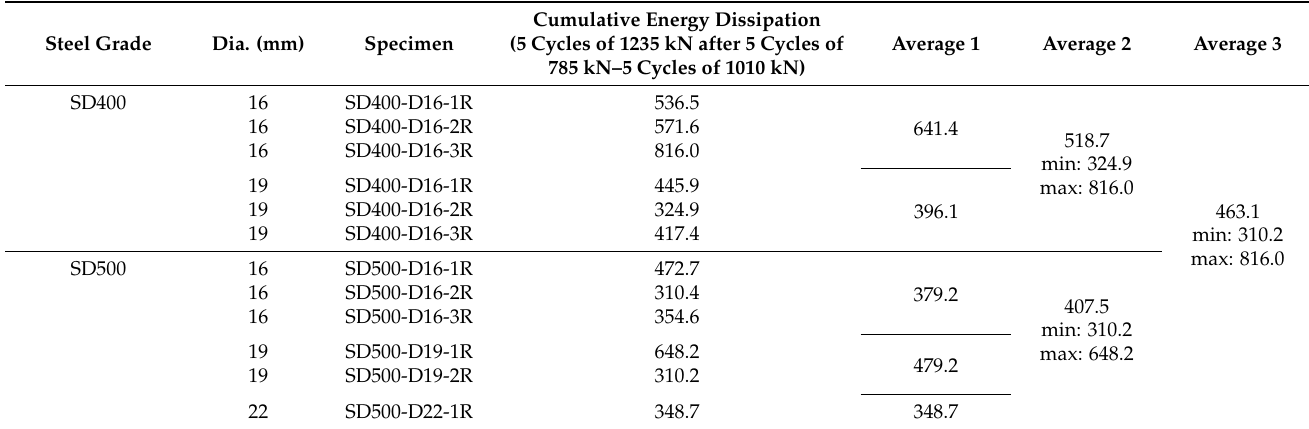
Table 15. Energy dissipation according to transverse rebar type (repeated load = 1235 kN) (unit = kN · mm). Steel Grade